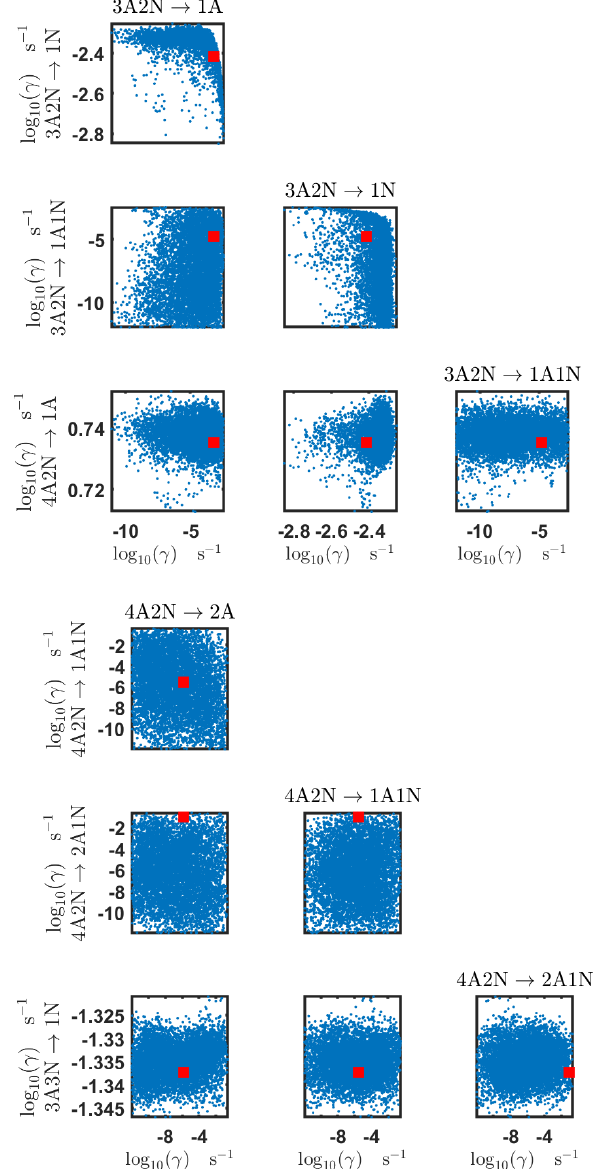
Figure B3. Pairwise marginal posterior distributions (for parameter indexes ranging from 1 to 8) of the base 10 logarithm of the evapora- tion rates (units given in s − 1 ) determined from steady-state cluster concentration measurements at the temperature 278K. Red rectan- gles denote the baseline values from Olenius et al. (2013b) used to generate the synthetic data. The notation xAyN corresponds to a cluster with x sulfuric acid and y ammonia molecules.